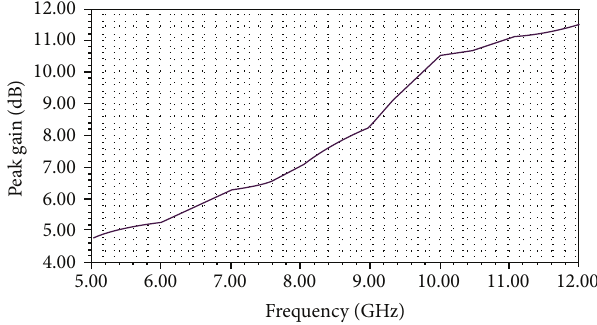
Figure 17: Measured Peak gain versus frequency plot.